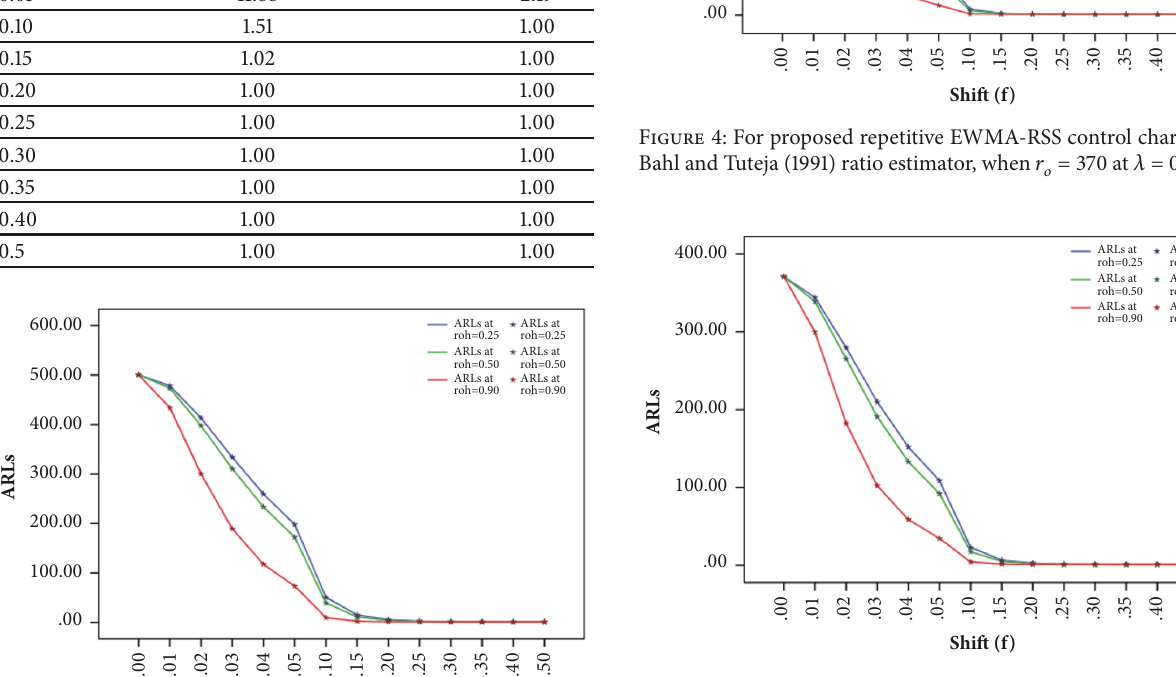
Figure 5: ARLs for proposed repetitive EWMA-RSS control chart using Bahl and Tuteja (1991) ratio estimator, when 𝑟 𝑜 = 370 at 𝜆 =